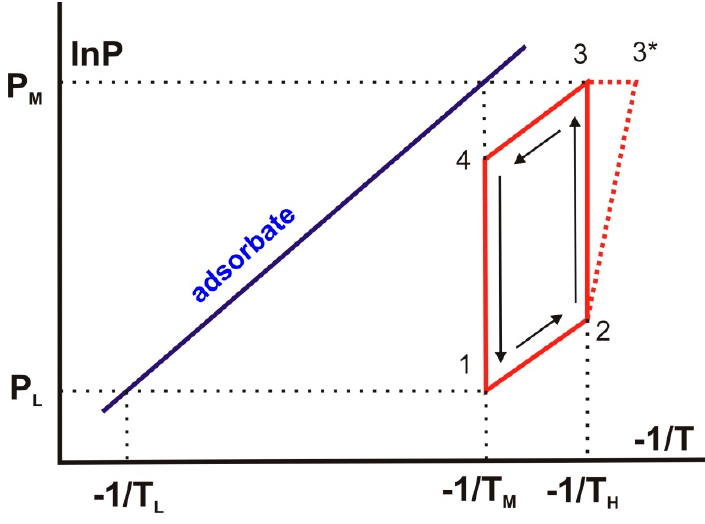
Figure 1. P-T diagram of the “heat from cold” (HeCol) cycle.